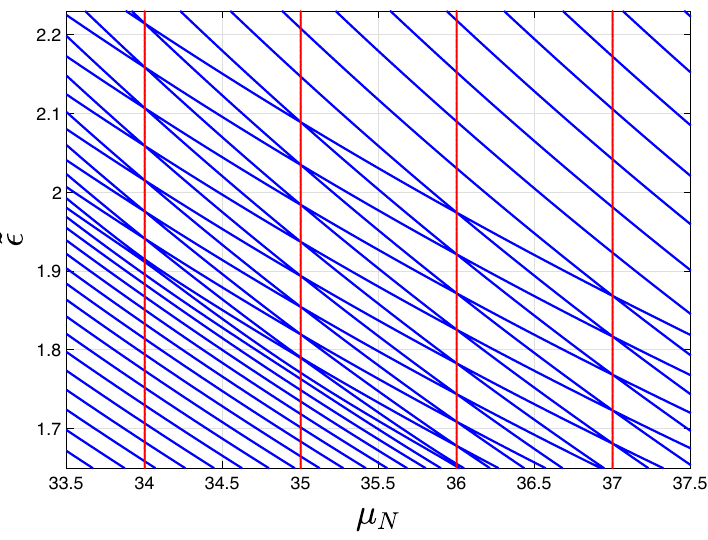
ε (α 1 α 2 )ε/(� α 2 N ) 2 (with ε denoting the unnormalized Figure 2. The dimensionless eigenenergies ˜ = + + 46 quanta at α 2 /α 1 eigenenergies) of the Hamiltonian (1) corresponding to the subspace with N = 0.32 g crit (see “Classical limit” section for the definition of g crit ) are shown � µ N (α 1 α 2 )/ 2 α 2 N , and g = = + − as functions of µ N . All the anti-crossing points are located on the vertical lines corresponding to integer values of µ N